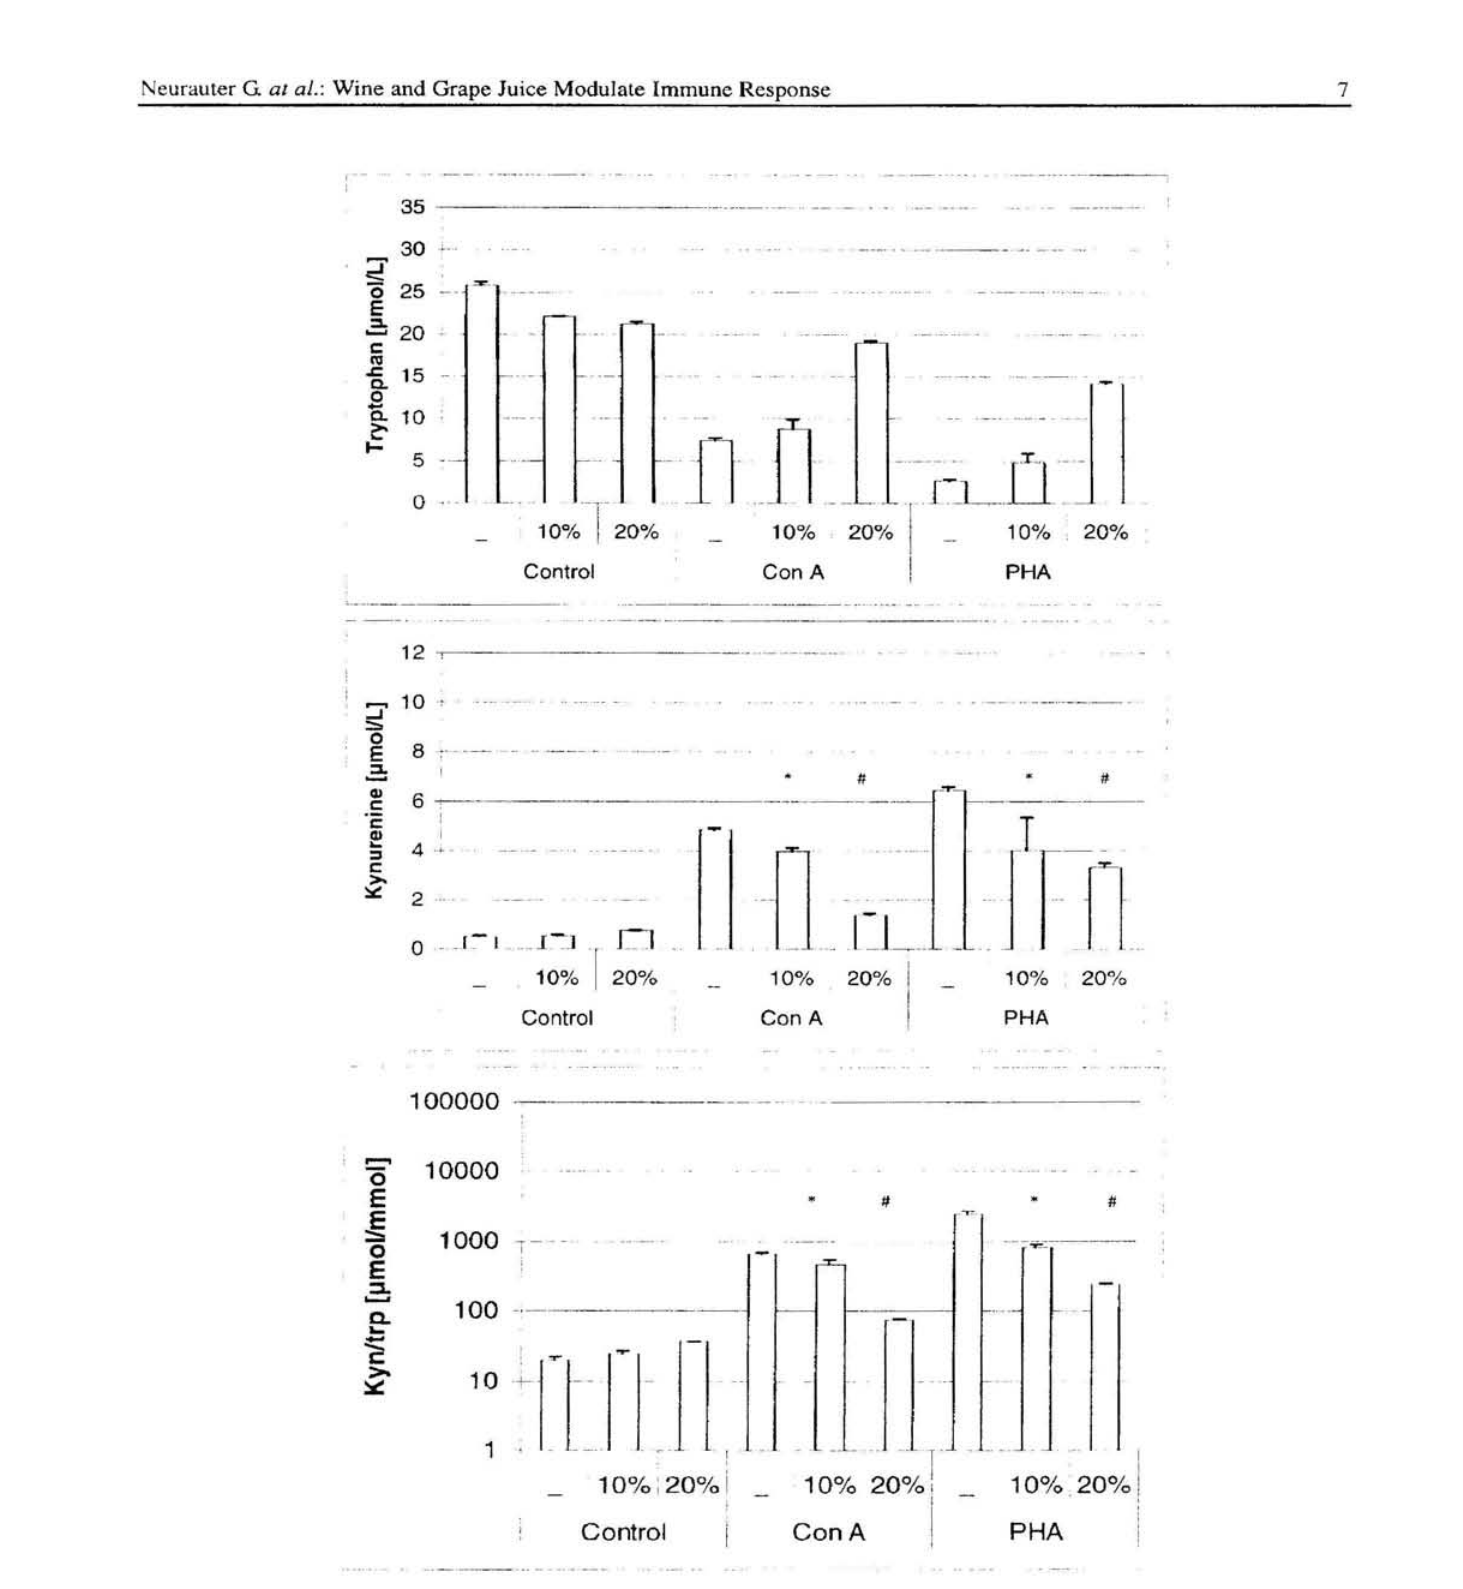
Figure 5. Influcncc of grape juice on tryptophan degradation in peripheral blood rnononuclear cells induced by rniiogens concanavalin A (Con A) and phytohaemagglutinin (PHA). Tryptophan degradation is calcuiated as the kynurenine per tryptophan ratio (Kyn/trp) which indicates indoleamine (2,3)-dioxygenase activity; 1:10 (= 10% v/v) and 1:5 (= 20% v/v) dilutions of grape juice in RPMI were tested (columns show means + S.E.M.; *p<0.05, #p <0.01; note log-scale of kyn/trp)